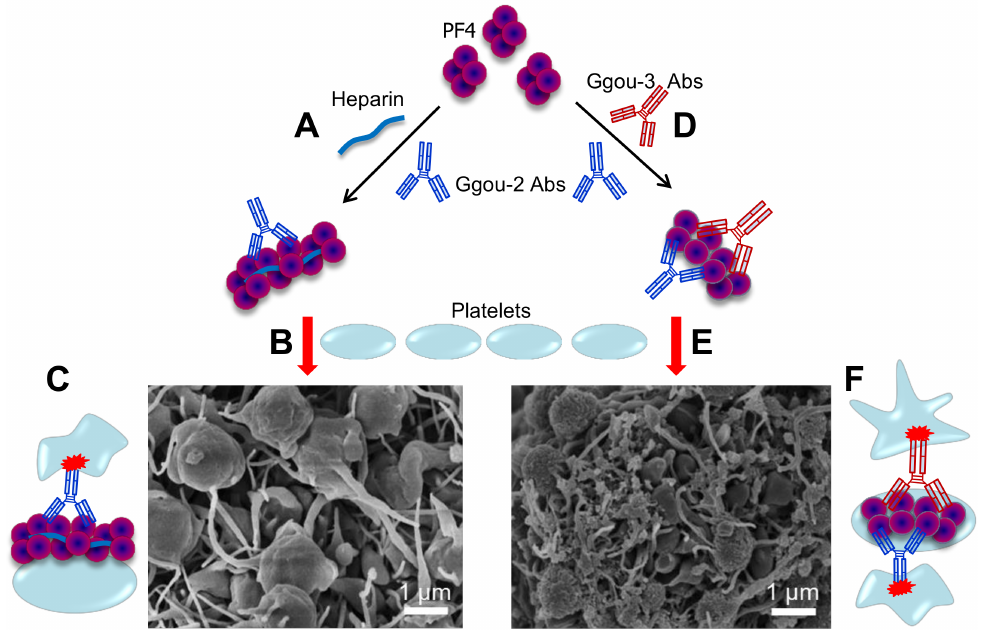
Figure 5. Typical HIT vs. autoimmune HIT. ( A ) PF4 form large complexes with heparin and the resulting PF4/H complexes allow binding of group-2 Abs blue which will then bridge platelets to form large platelet aggregates and activate them ( B ) via Fc receptor (( C ), red), resulting of a typical HIT. ( D ) A subset of group-3 Abs (red) mimic heparin in clustering PF4, forming PF4/Group-3 antibody complexes which also allow binding of group-2 Abs, inducing platelet aggregation and activation ( E ), resulting of autoimmune HIT ( F ) Complex formed by group-3 antibody contains at least two pathogenic antibodies, both bind to platelet membrane, and therefore, enhanced platelet